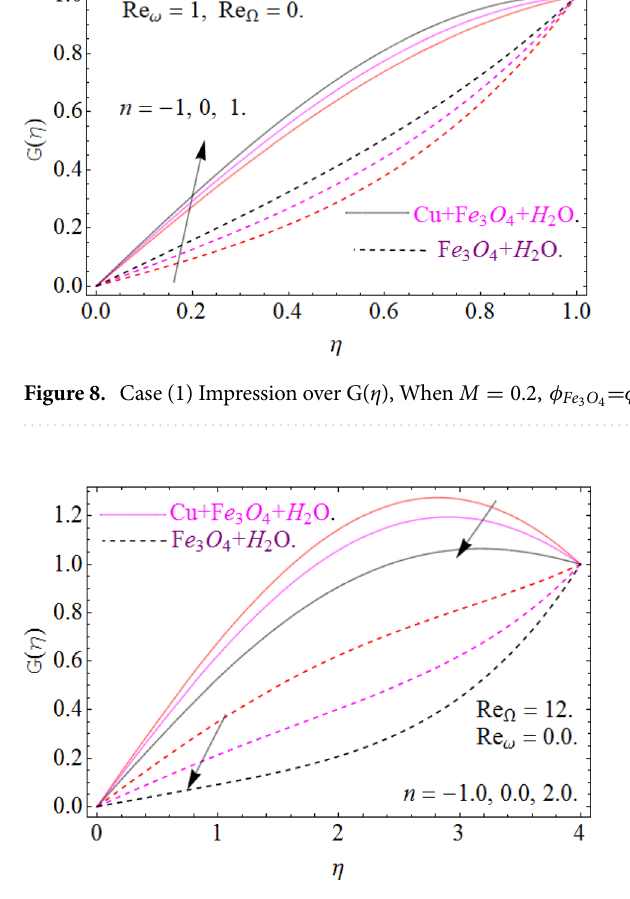
Figure 9. Case (2) on the G( η ), When M = 0.2, φ Fe 3 O 4 = 0.4, φ Cu = 0.2, Ec = 0.1, Pr = 6.2